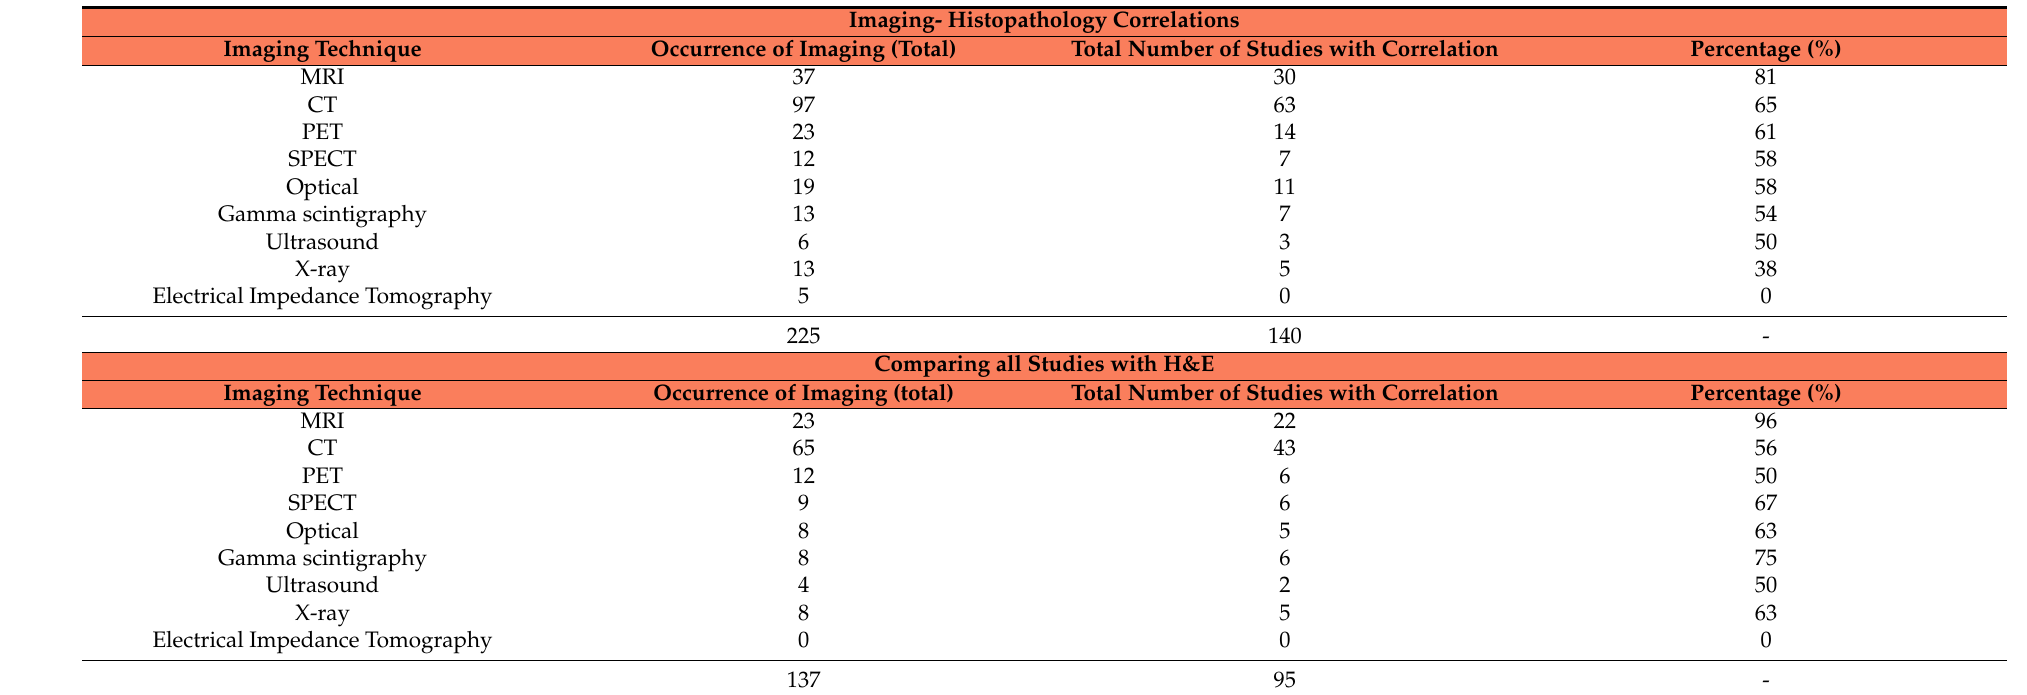
Table 8. Number of studies with imaging and histopathological